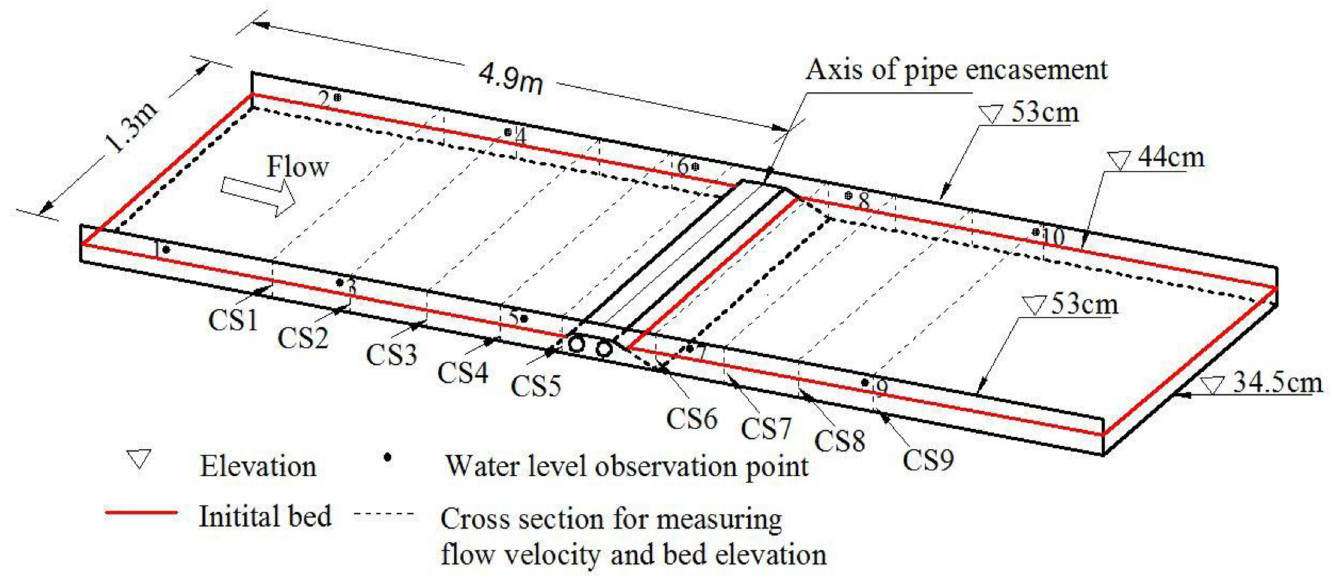
Fig 1. Schematic view of the model layout (not to the